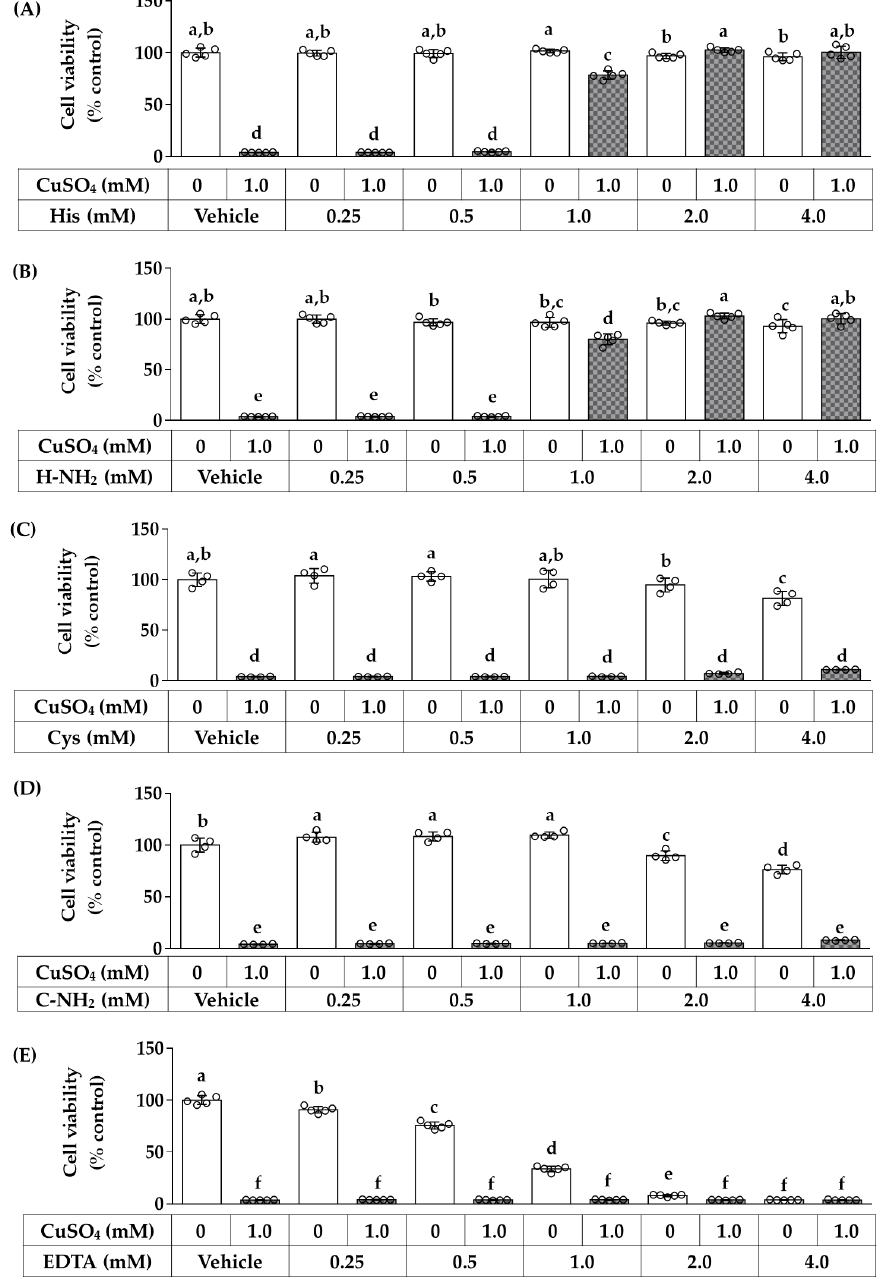
Figure 4. Effects of histidine ( A ), histidinamide ( B ), cysteine ( C ), cysteinamide ( D ), and EDTA ( E ) on the CuSO 4 -induced cytotoxicity. HaCaT cells were treated with a test material at varying concen- trations in the absence and presence of 1.0 mM CuSO 4 for 48 h. Cell viability was presented as % of the control group (mean ± SD, n = 4 or 5). Different lowercase letters (a–f) indicate significantly different means at the p < 0.05 level.